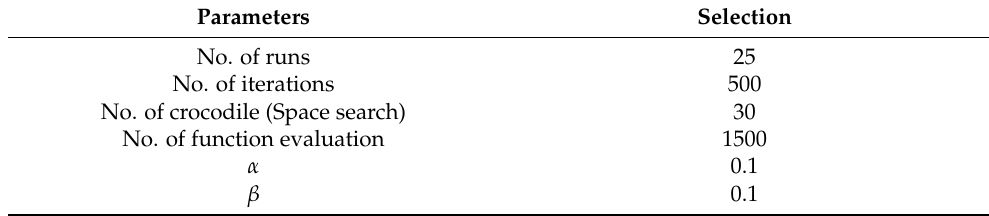
Table 2. Computational parameters.